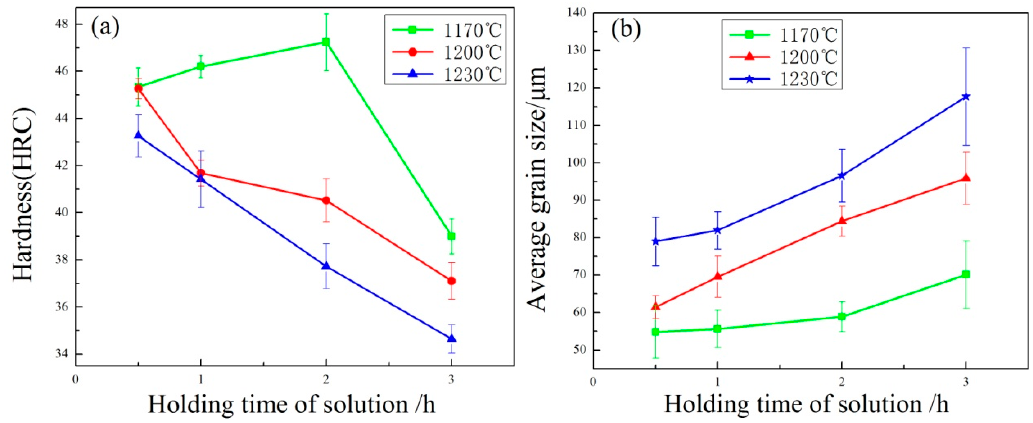
Figure 7. Rockwell hardness ( a ) and austenite average grain size ( b ) after various holding time at different solution temperatures.